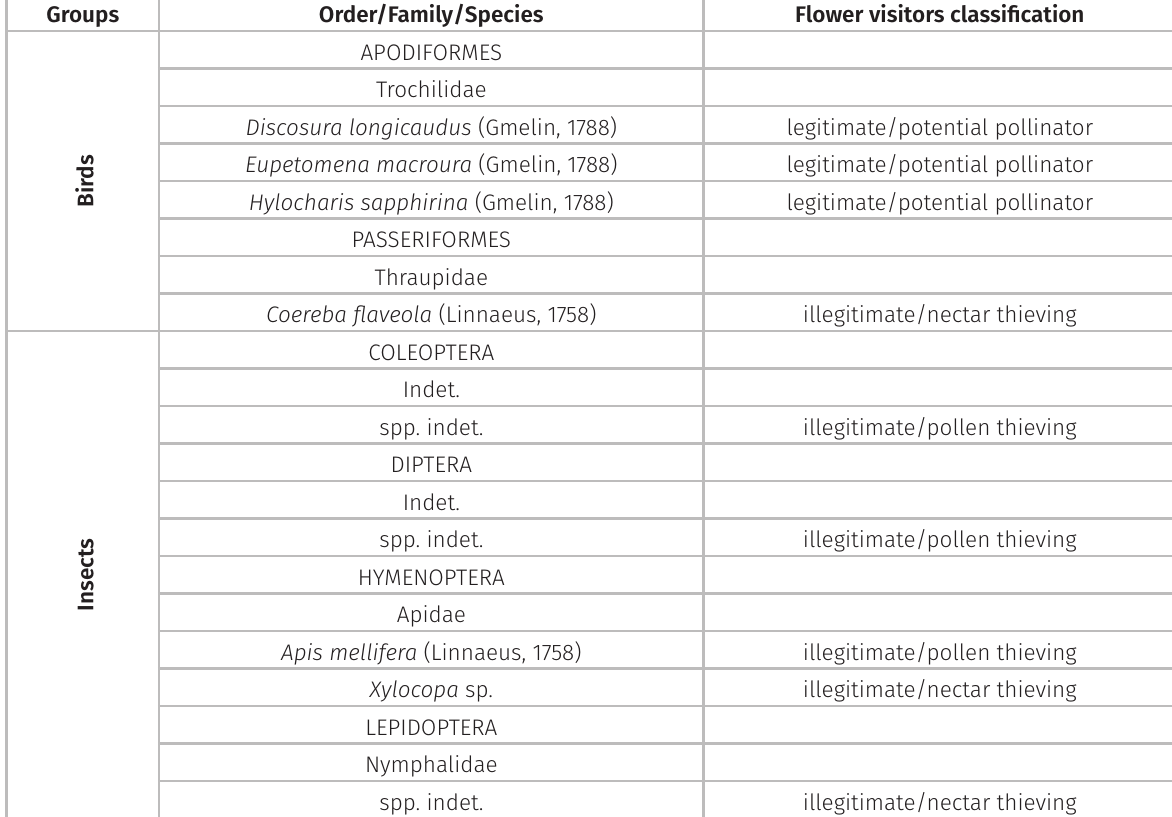
Table II. Floral visitors of Hymenaea oblongifolia var. latifolia Y.T. Lee & Langenh. in a rain forest area, Ibirapitanga, Bahia State, Brazil. Flower visitor classification follows Inouye (1980) terminology.